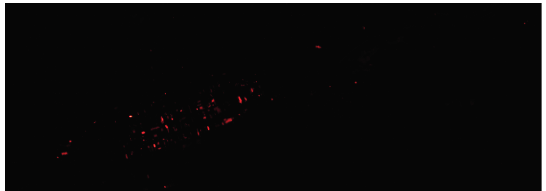
Figure 14. 2-D plots of the detection results of the RX